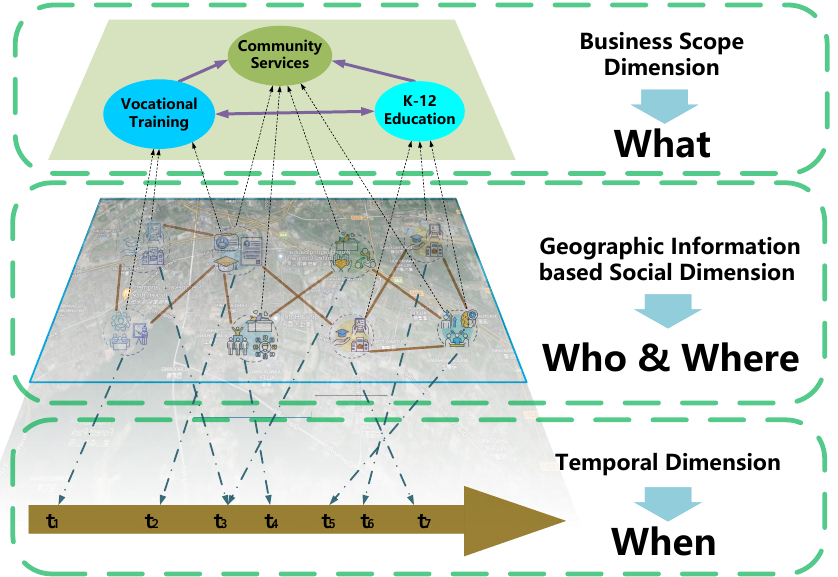
Figure 4. A concept map that has analyzed the geographic information system of social